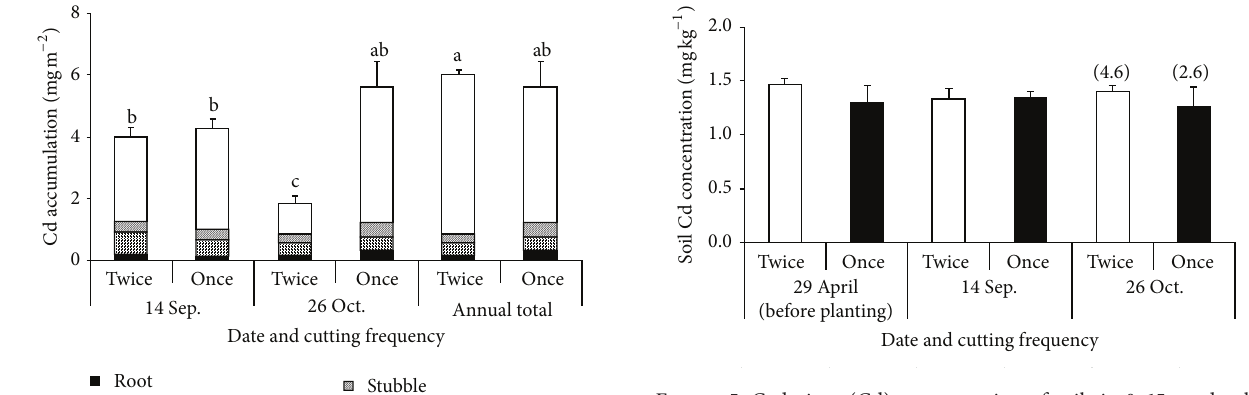
Figure 5: Cadmium (Cd) concentration of soils in 0–15 cm depth before planting and following the first and second cuts from plots after a single (Once) or two cuttings (Twice). Mean ± standard deviation ( 𝑛 = 3 ). Figures with parenthesis show the decreasing percentage from Cd concentration before